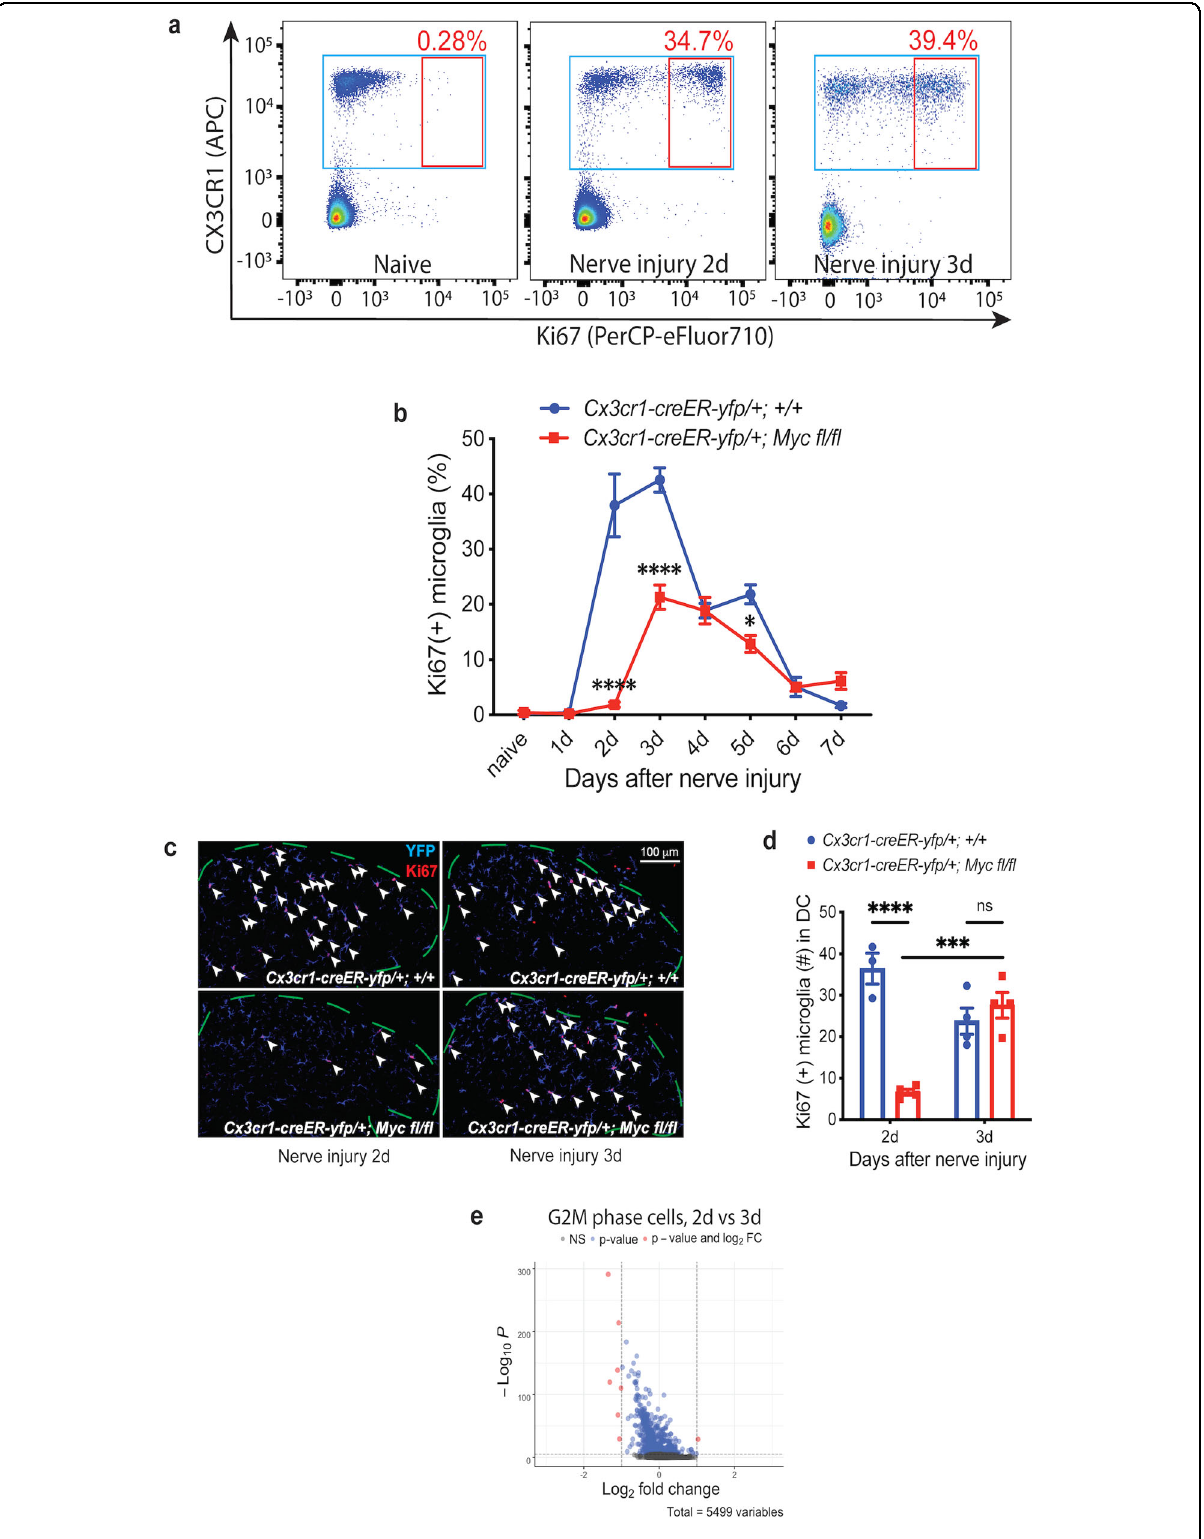
Fig. 2 (See legend on next